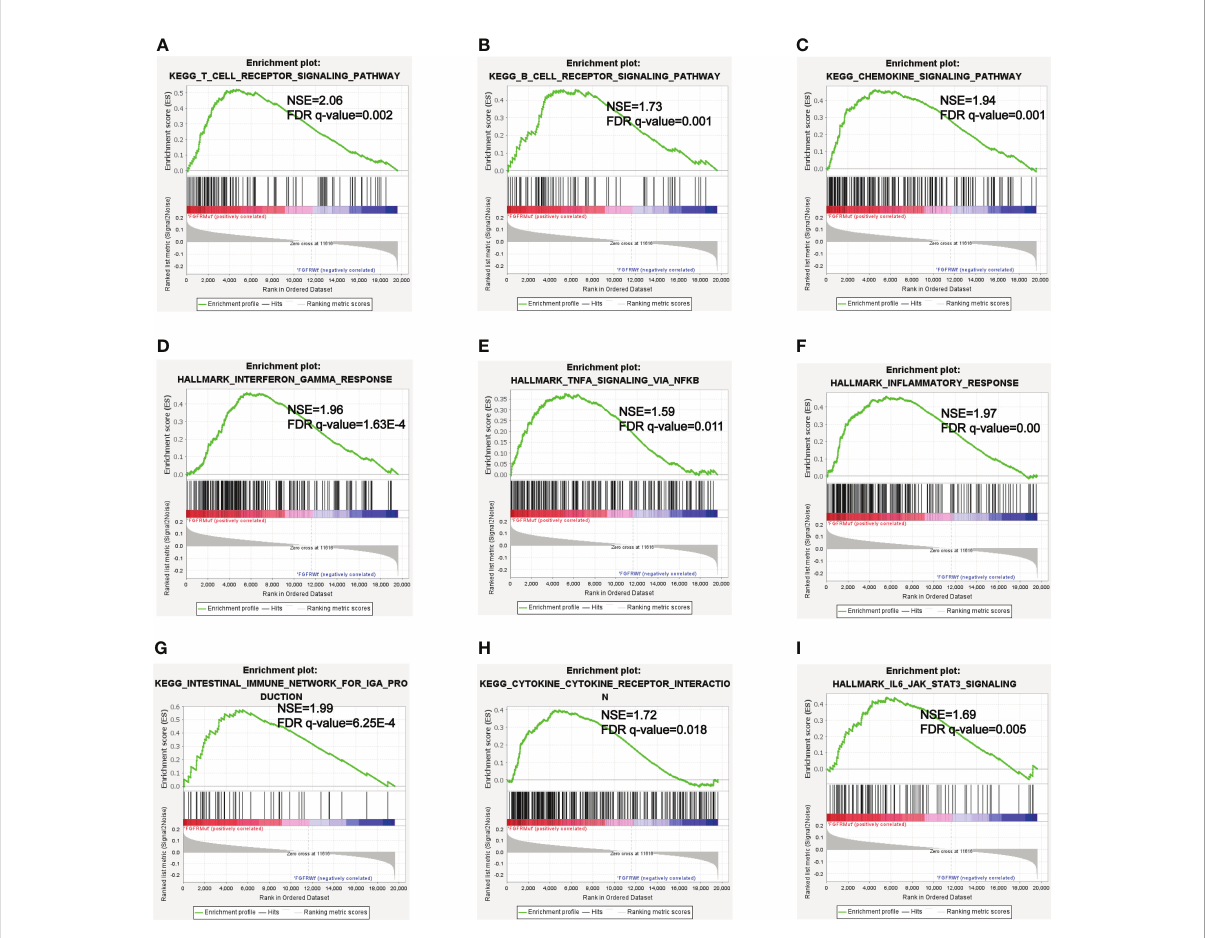
FIGURE 9 (A-I) Enriched Gene Sets in FGFR Mut and FGFR Wt